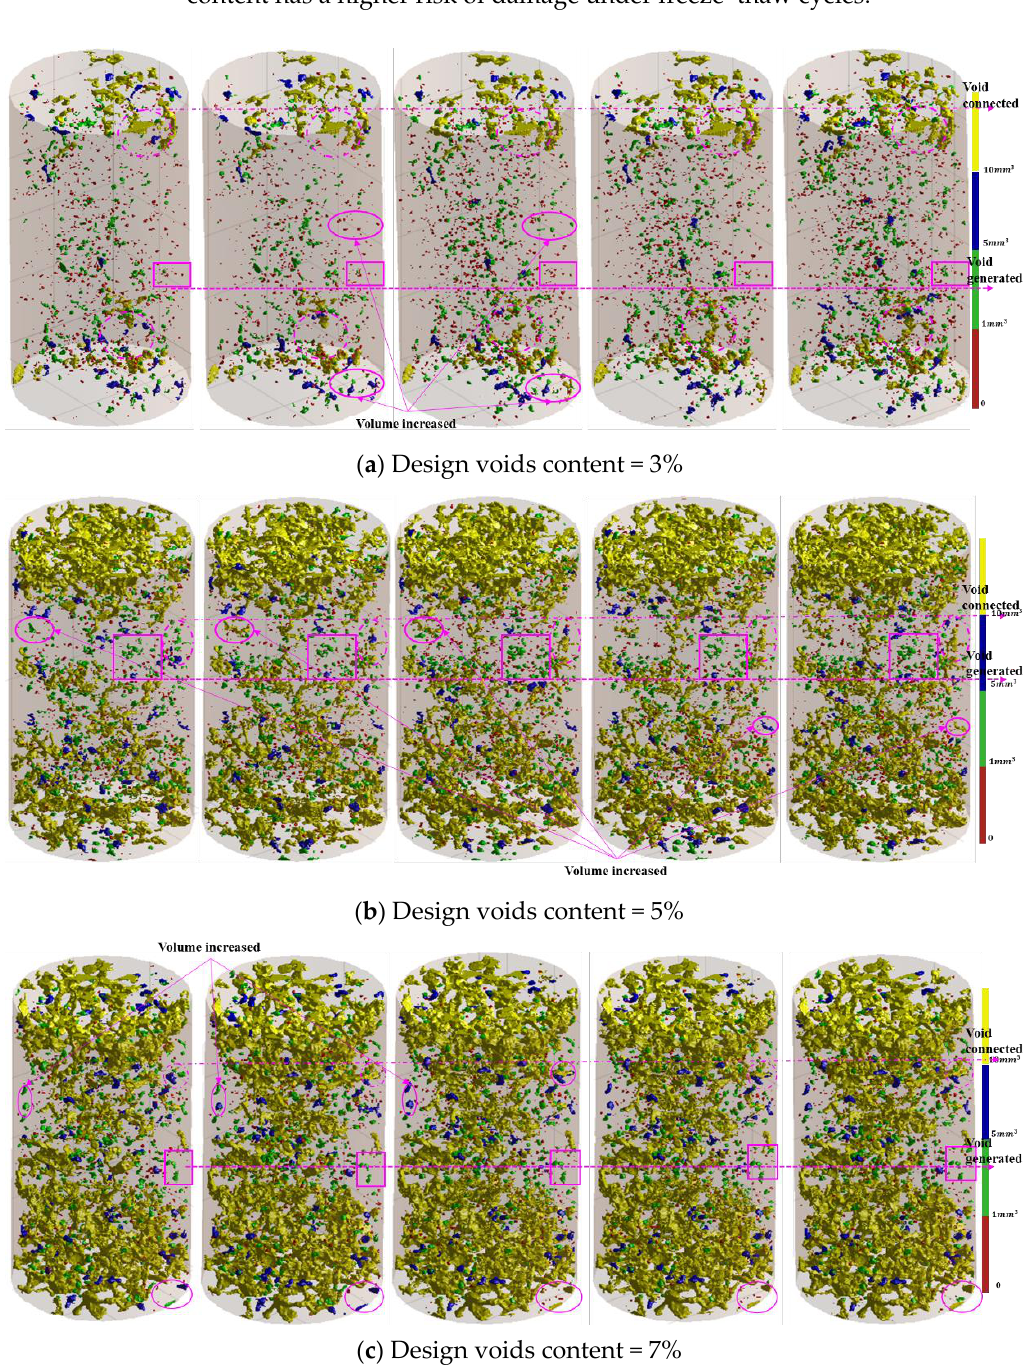
Figure 6. Comparison of air void in 3D of different specimens during freeze–thaw test (from left to right in Figure 5), the 3D air voids images of sample are stand for 0, 5, 15, 25, and 35 freeze–thaw cycles in order).